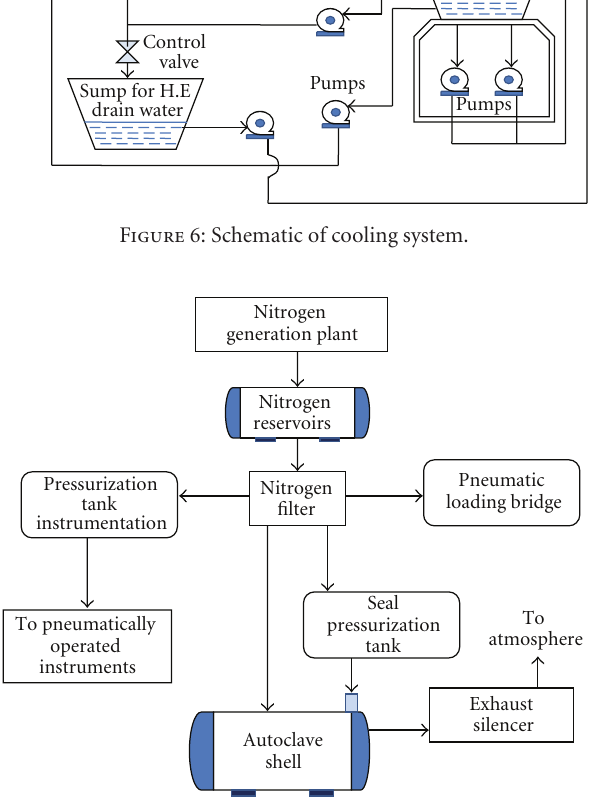
Figure 7: Schematic of pressurization